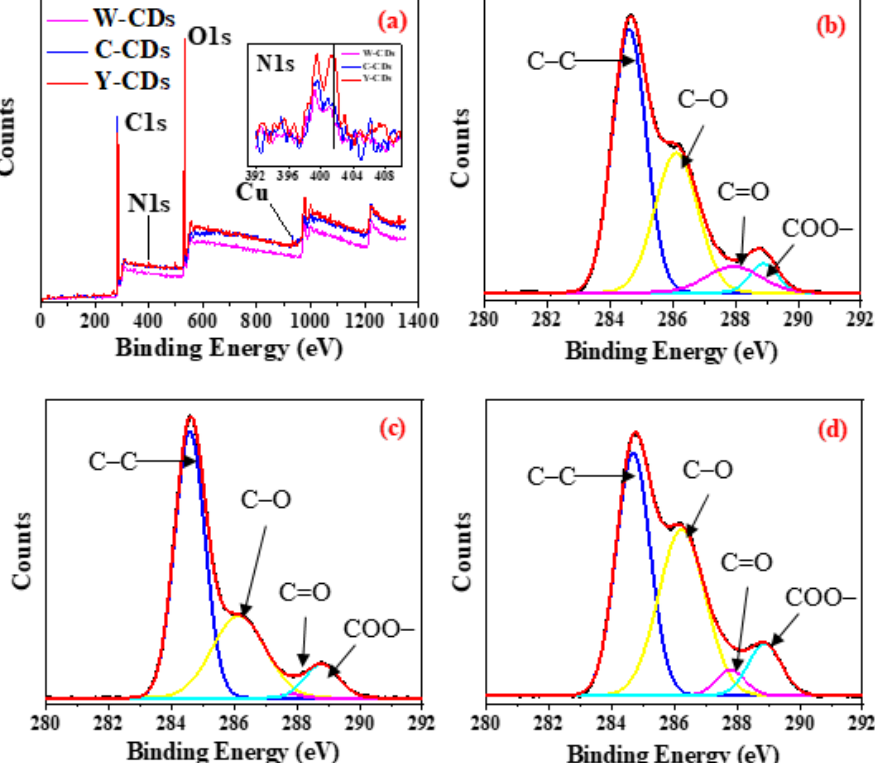
Figure 3. XPS full scan survey spectrum of the synthesized CDs and partially enlarged XPS spec- trum of N1s in upper right illustration ( a ); high-resolution XPS spectrum of C1s for W-CDs ( b ), C-CDs ( c ), and Y-CDs ( d ).